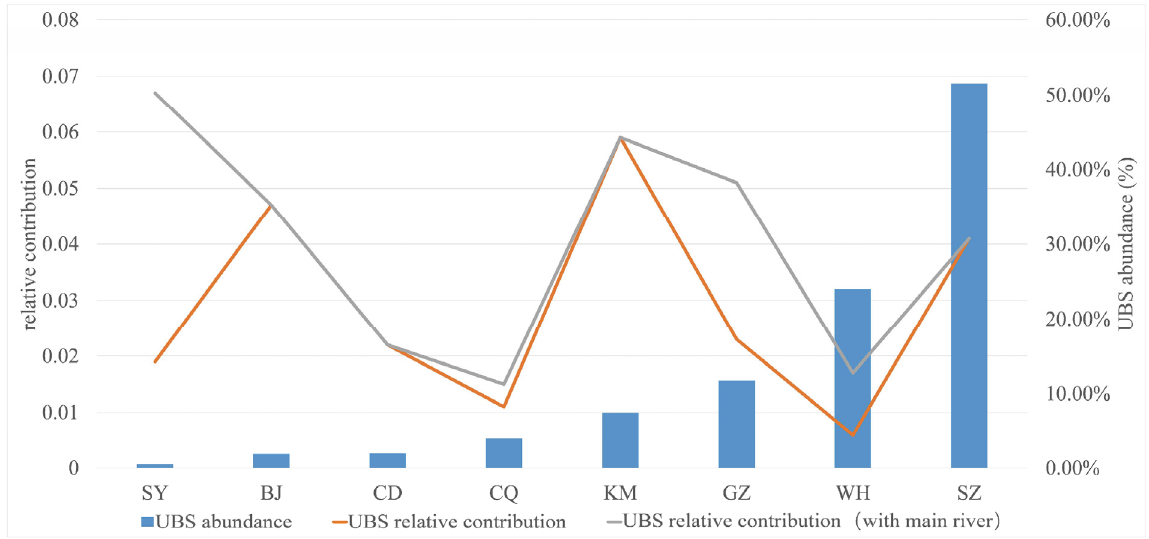
Figure 5. Urban blue spaces (UBS) abundance and UBS relative contribution for Model I and Model II.